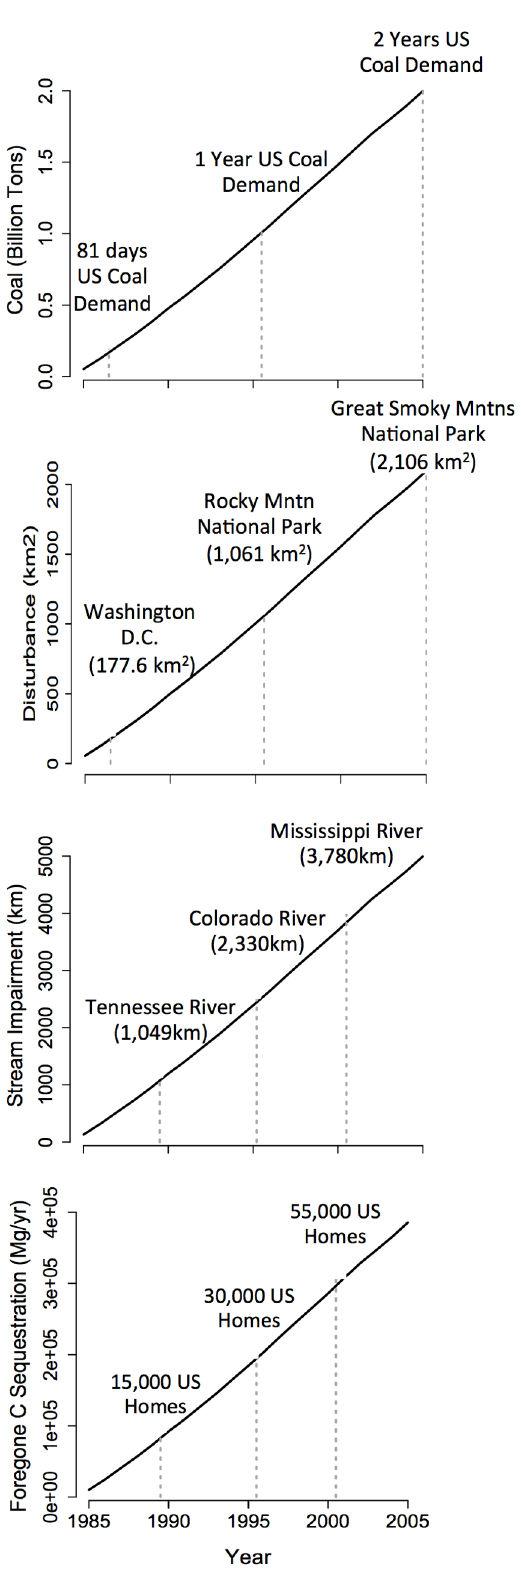
Figure 2. Scaling the environmental costs of coal production. Cumulative surface coal production across the 47 county study area is shown for the period 1985–2005 (A). Cumulative surface mining disturbance (B), stream length impairment (C), and forgone C